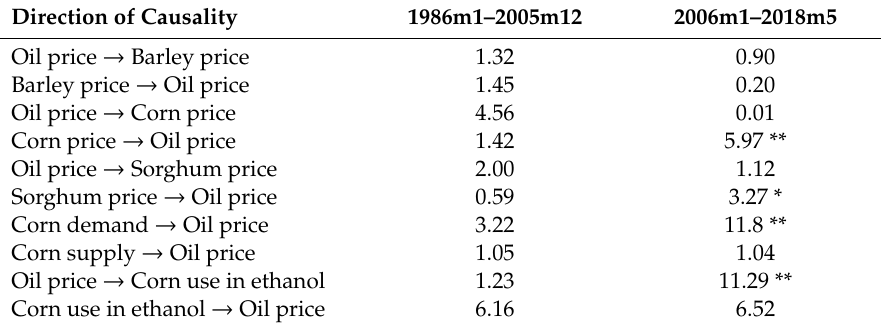
Table 3. Granger causality.